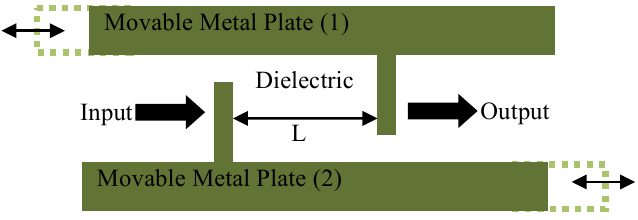
Fig. 6. Schematic diagram to the horizontal movement of the plasmonic